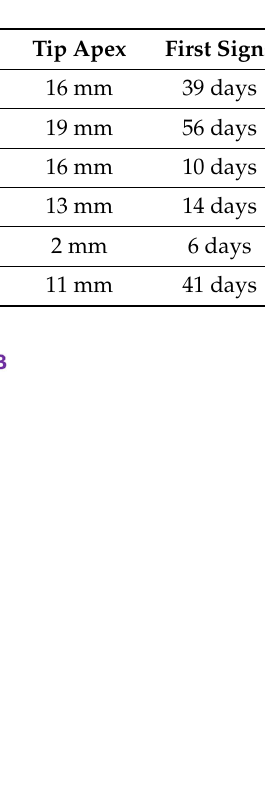
Table 2. All patients with mechanical failure.